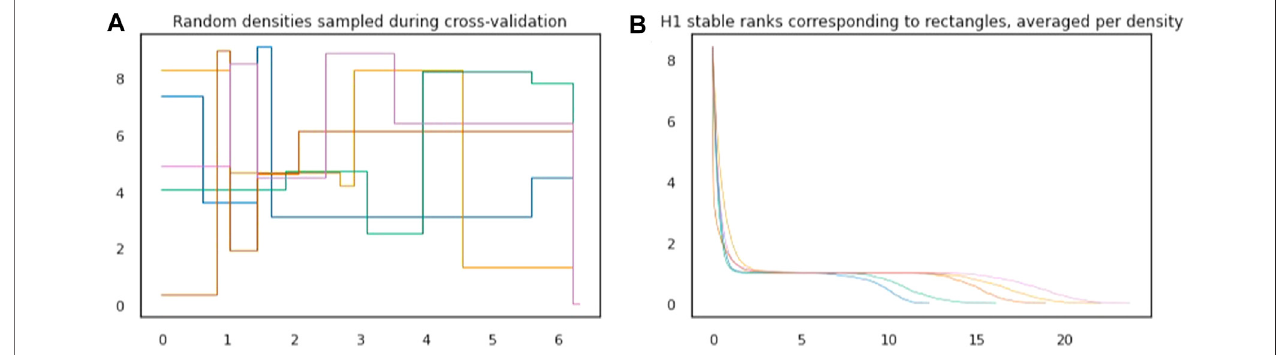
FIGURE 5 | (A) : Examples of fi ve densities randomly sampled during cross-validation. (B) : For plane fi gures in the dataset corresponding to the rectangle, stable ranks are computed under the fi ve different densities from the left plot. Average stable ranks are plotted with the same color as the density under which they were computed.